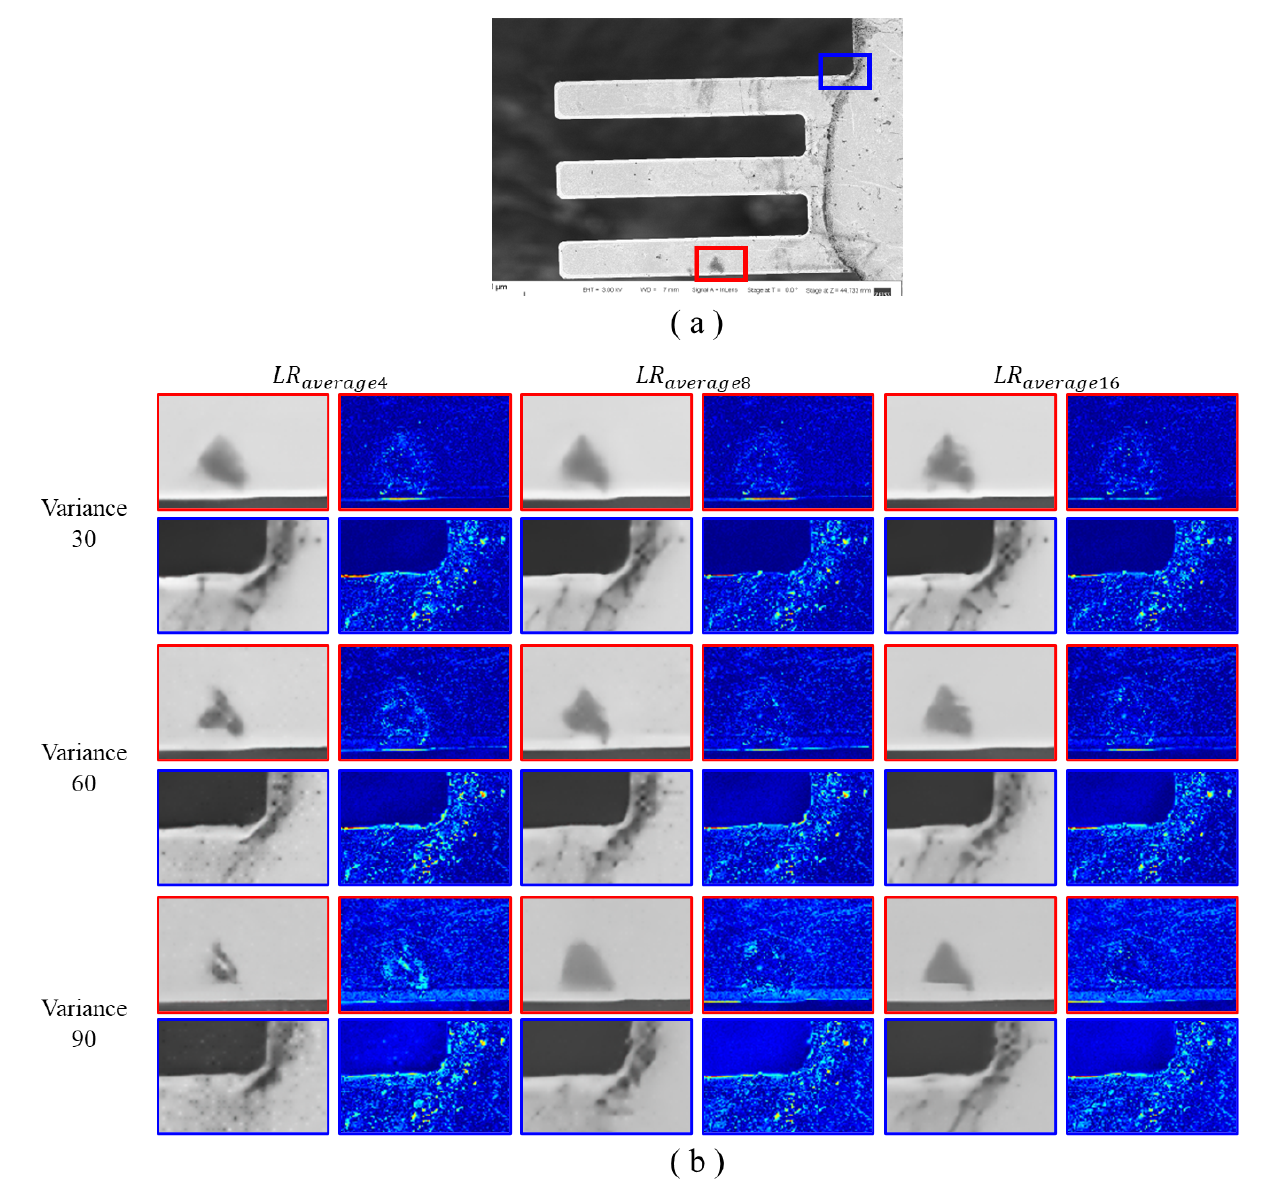
Figure A3. Qualitative comparison of our proposed scheme for different noise levels and different numbers of averaged images during denoising: ( a ) full-resolution image is the HR target image, which is given as a reference for the positions of the magnified boxes; ( b ) magnified images and error map illustrated in the heat map for reference ( a ). Images are evaluated for different noise levels (variances of 30, 60, and 90) and different numbers of averaged images for denoising (4, 8, and 16 images used). The red and blue boxes show the magnified SR results and the error map trained for each setting for LR average images at each noise level, respectively. The error map is illustrated as a heat map, with the error between the SR and target HR images amplified five times for visual comparison. The baseline network chosen is